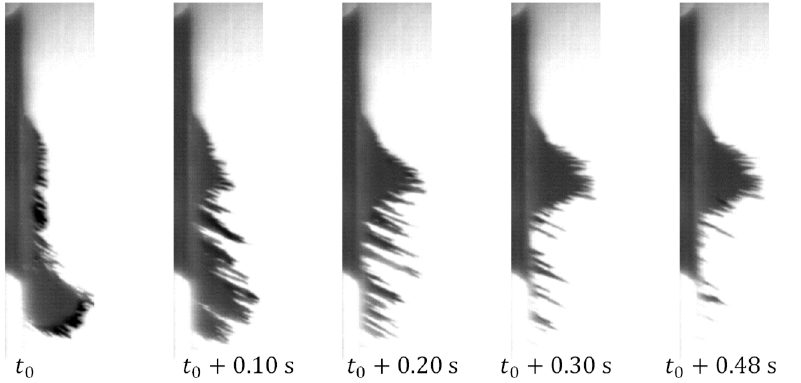
Figure 9. The evolution of a bulk of 100 mg during pulse of 50% duty